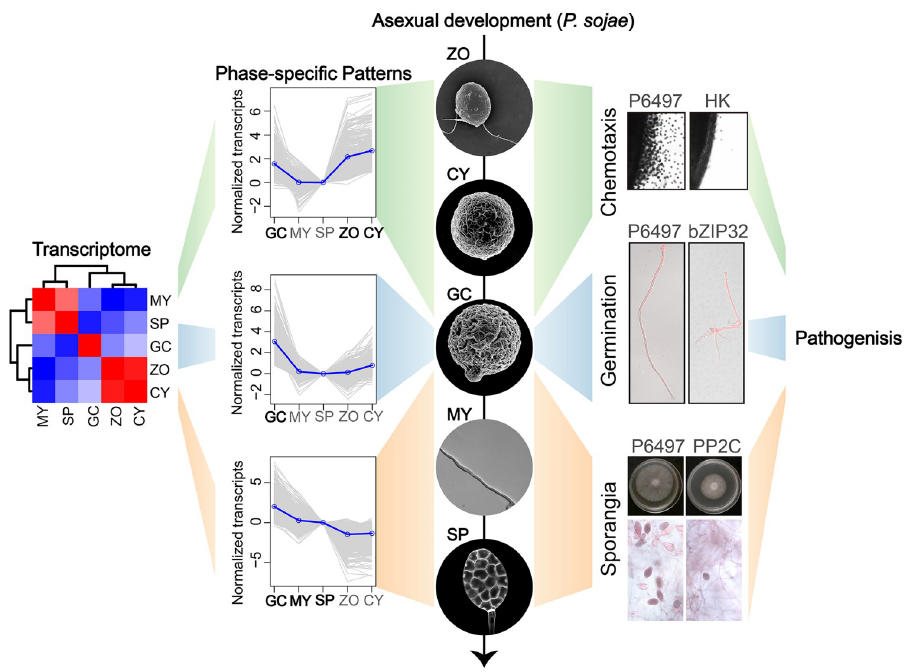
Fig 7. Transcriptional profiling identifies novel functional genes of P . sojae associated with asexual development and pathogenesis. This model proposes a possibility to study phase-specific genes that may play essential